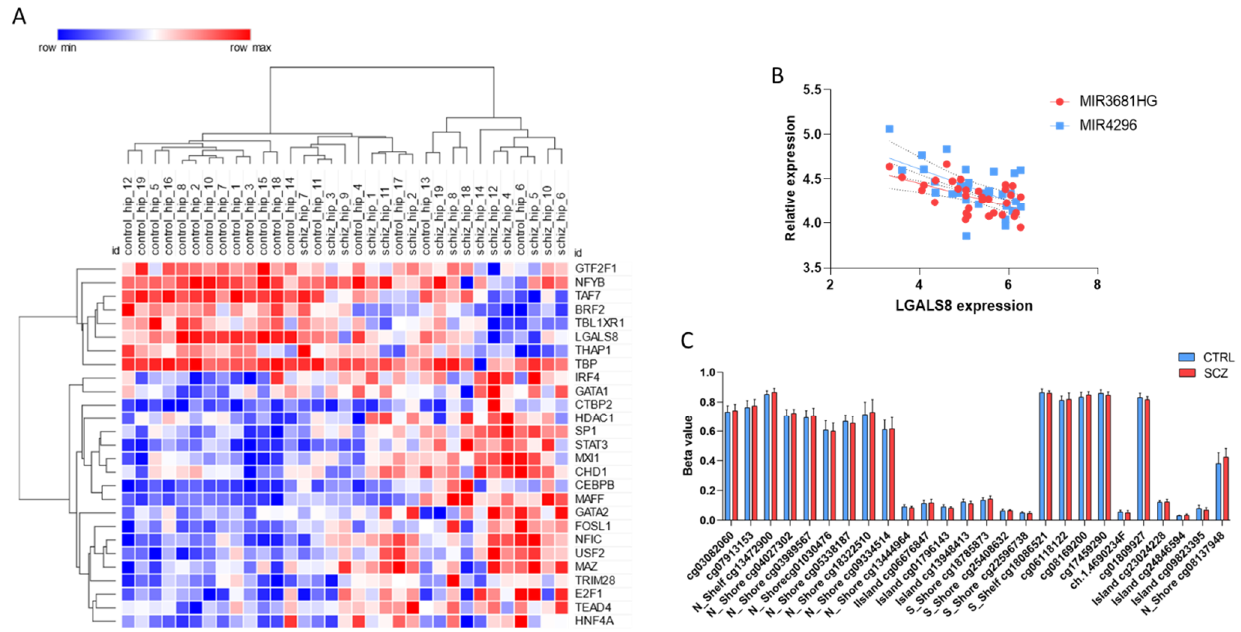
Figure 3. Regulation of LGALS8 expression in SCZ brain. ( A ) Hierarchical clustering of the transcription factors predicted for LGALS8 in the SCZ hippocampus, as determined in the GSE53987 dataset. ( B ) Correlation between LGALS8 expression and MIR3681HG and MIR4296 , as determined in the GSE53987 dataset. ( C ) Methylation levels of the LGALS8 gene in the hippocampus from SCZ patients and control donors, as determined in the GSE89703 dataset.